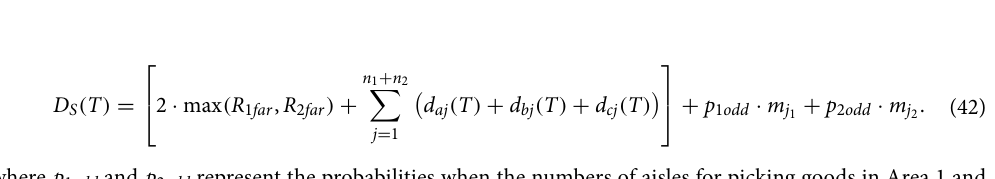
Table 4. Probabilities of the distribution of the classes of items to be picked in the